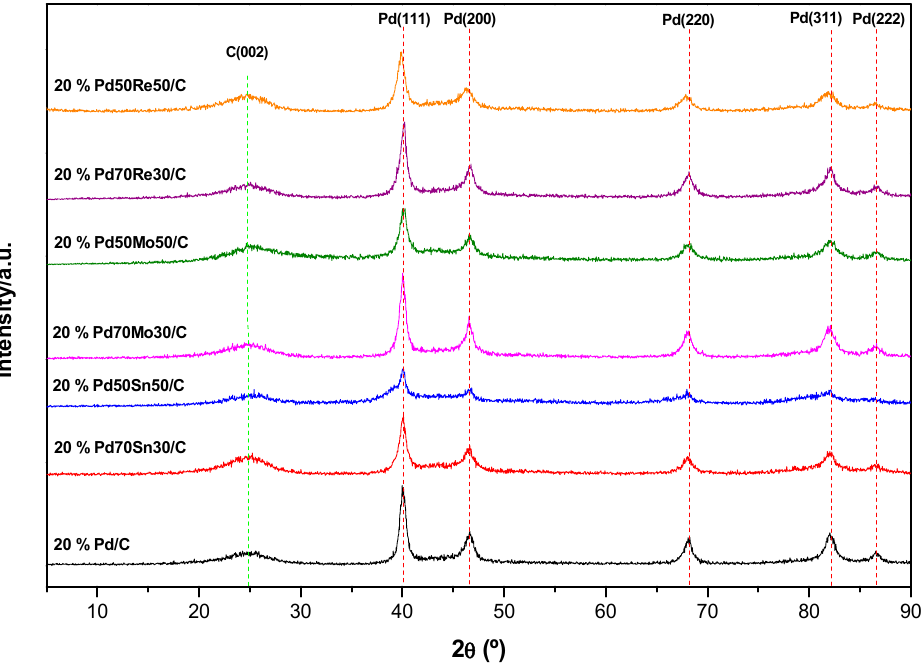
Figure 1. XRD diffractograms of 20% Pd/C and the bimetallic samples of 20% Pd-metal/C.